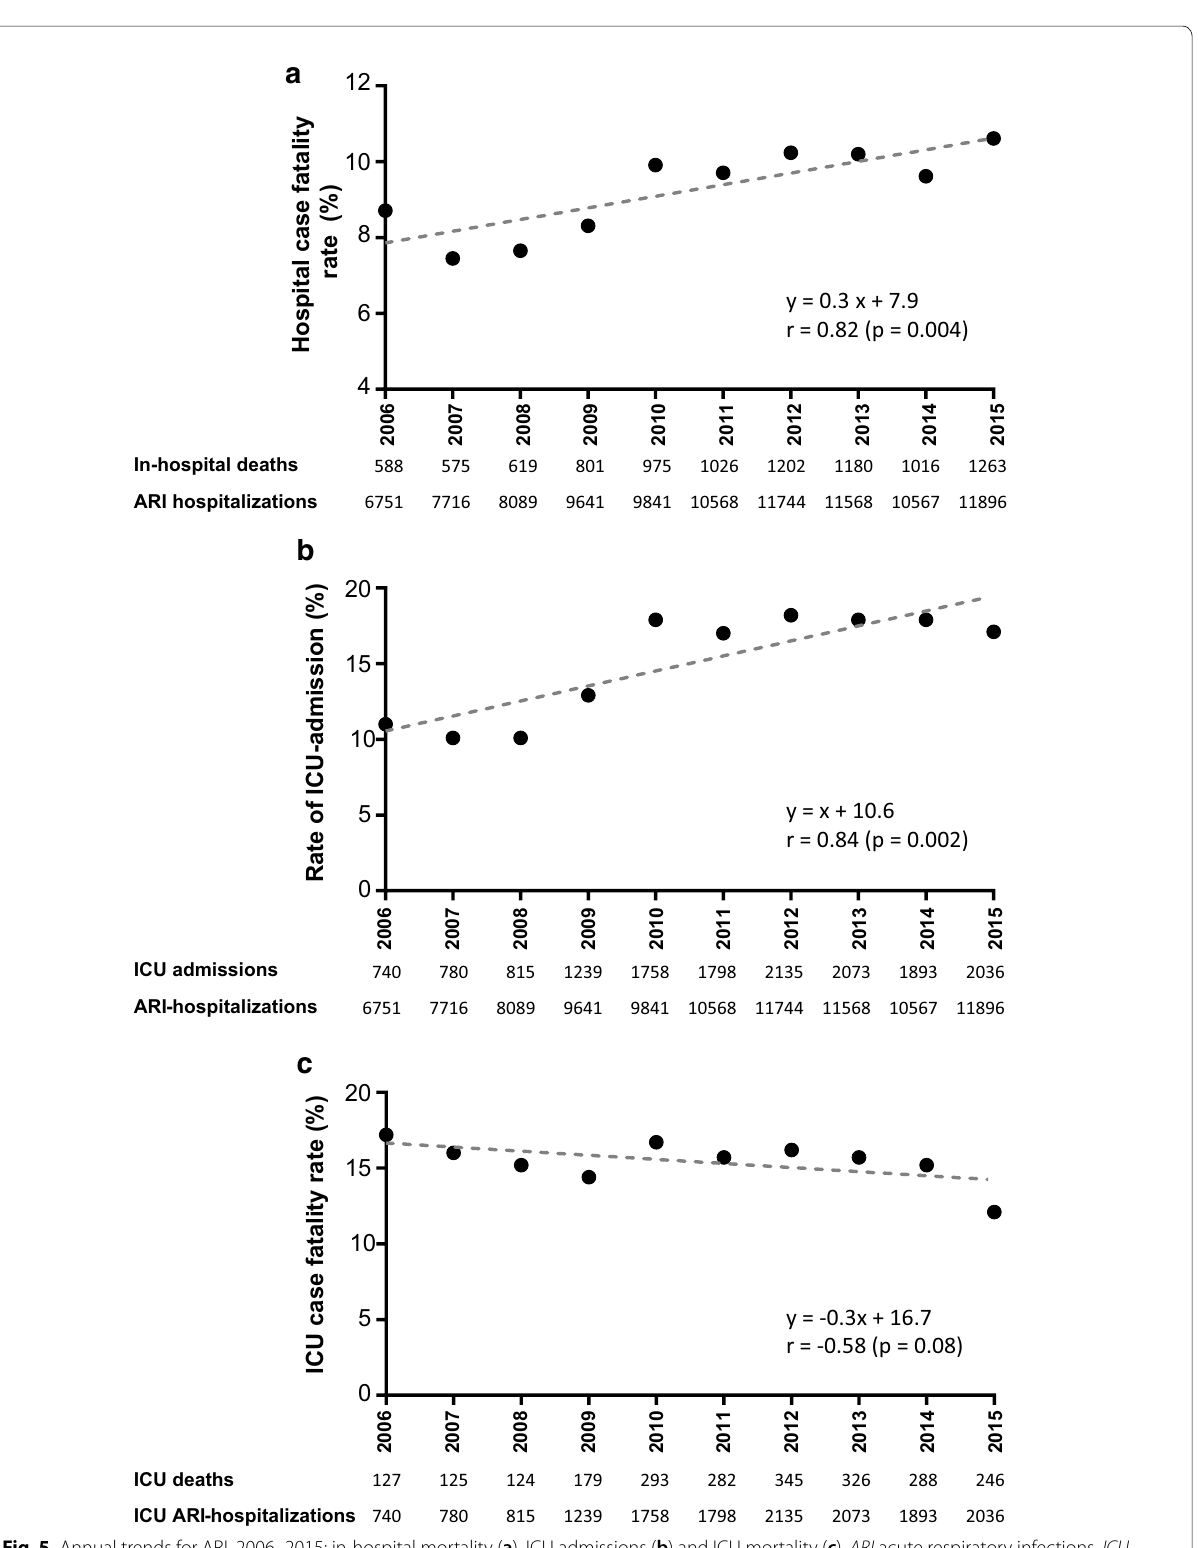
Fig. 5 Annual trends for ARI, 2006–2015: in‑hospital mortality ( a ), ICU admissions ( b ) and ICU mortality ( c ). ARI acute respiratory infections, ICU intensive care